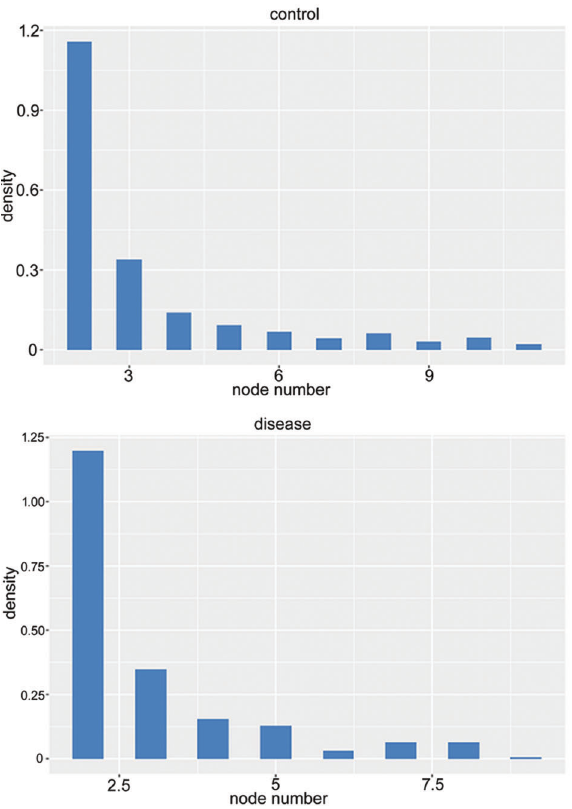
Figure 1. Pearson correlation coef fi cient distribution of interac- tions in the nasopharyngeal carcinoma group and the control group.